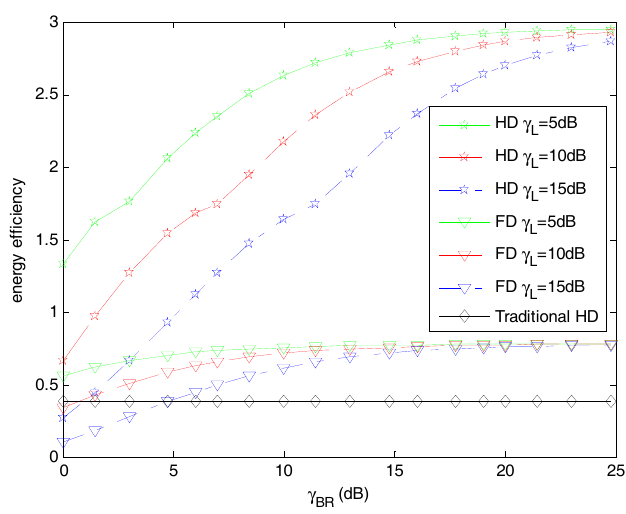
Figure 6. Sum transmit power consuming with different SINR from the base station to the D2D relay.